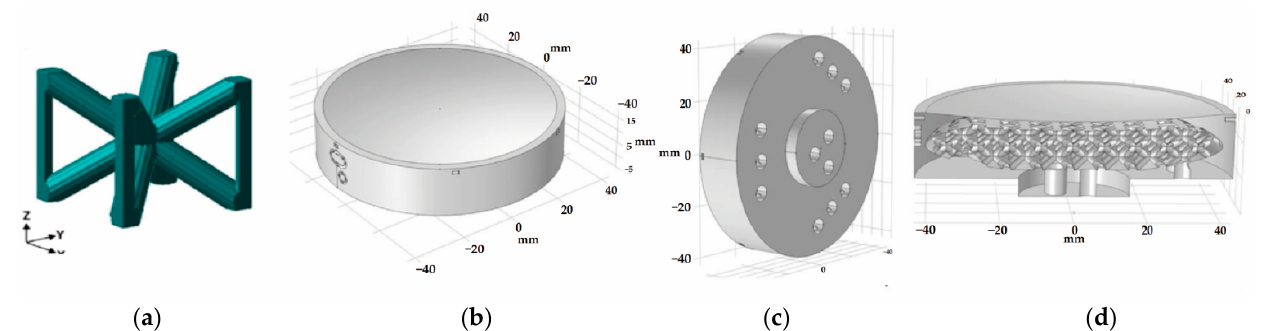
Figure 24. ( a ) BCCz image; ( b − d ) A CAD representation and the internal structure of the AM mirror to print [64].